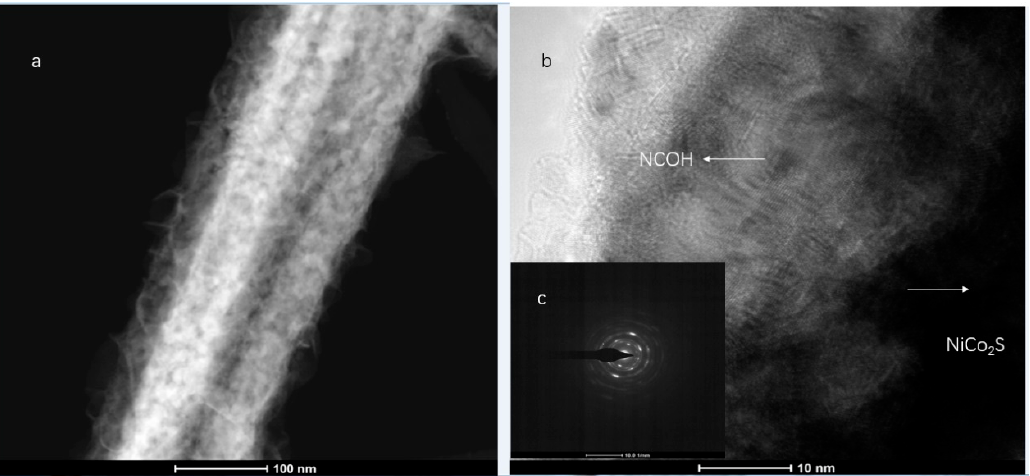
Figure 5. ( a ) TEM and ( b ) HRTEM images of individual NiCo2O4@NiCo2O4 hierarchical nanostructures and (c) inset showing the SAED.